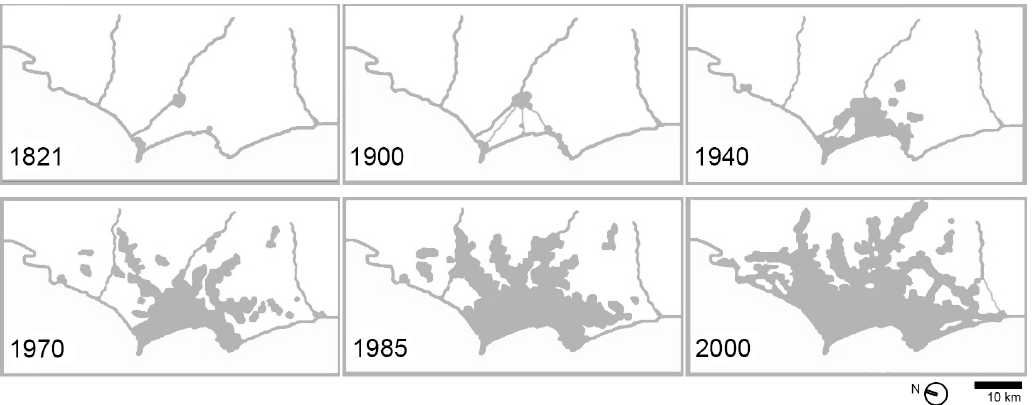
Figure 1. Historical evolution of the city of Lima. Source: Reference [11].